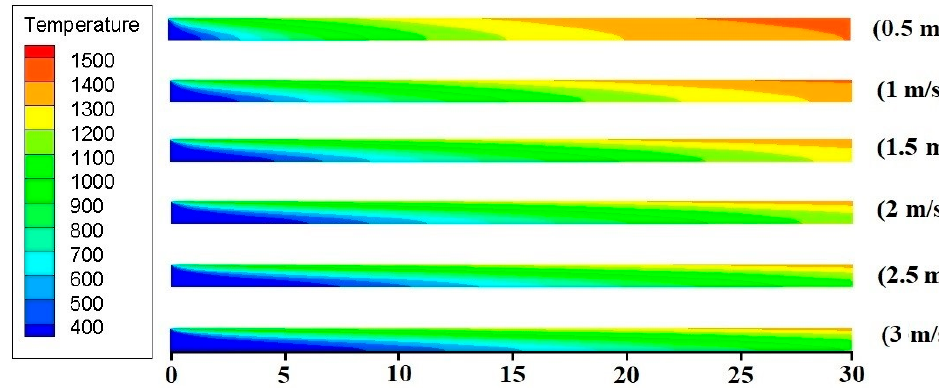
Figure 13. Distribution of exhaust temperature with different injection flow rates. 2 (cid:13) Methane conversion rate